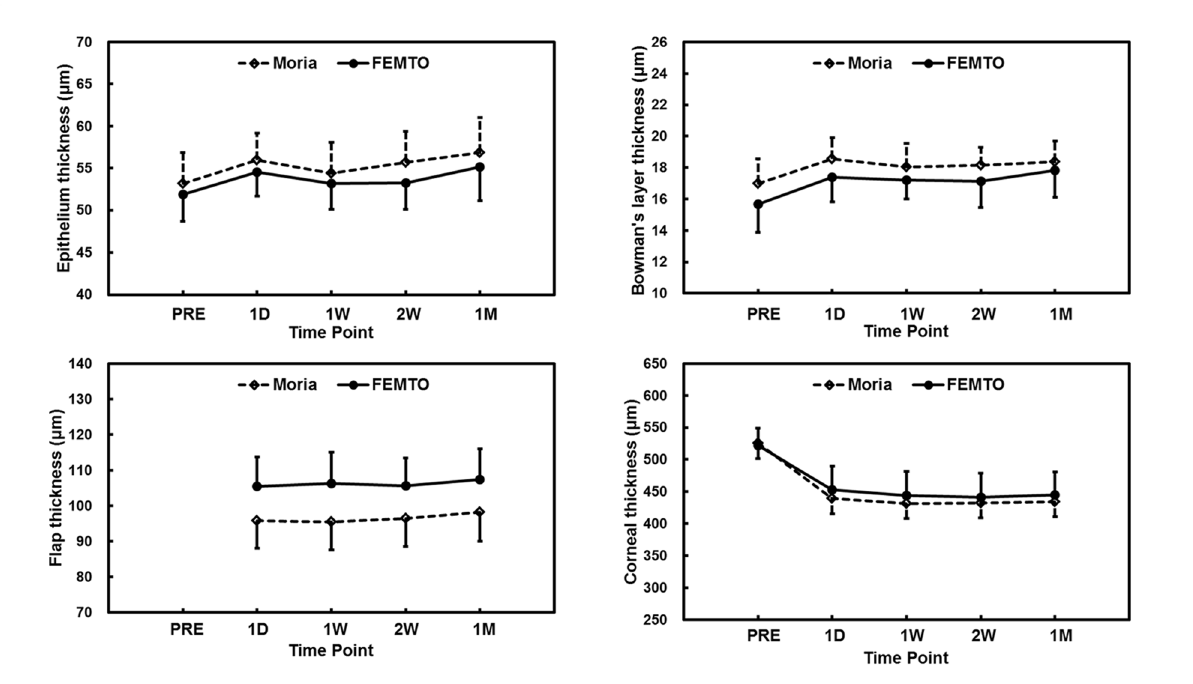
Fig 4. Thickness changes in the corneal sublayers of the Moria and FEMTO groups. (A) Epithelial thicknesses measured by UHR-OCT in both groups were increased sharply at 1 day after SBK, and then continued to increase to the end of the follow-up period at 1 month. (B) Bowman 0 s layer thicknesses also increased by 1 day after SBK, but then remained steady afterwards. (C). Changes in flap thicknesses for both groups were not significantly until the second week post-SBK. Between two weeks and one month, the increase in flap thickness was small but significant for both groups. (D) Total corneal thickness for both groups decreased sharply by 1 day after SBK. Though the decreases were small between 1 day and 1 week after SBK, they were significant. Small but significant decreases continued from 2 weeks through the end of the follow-up period. PRE, pre-SBK; D, day post-SBK; W, week post-SBK; M, month post-